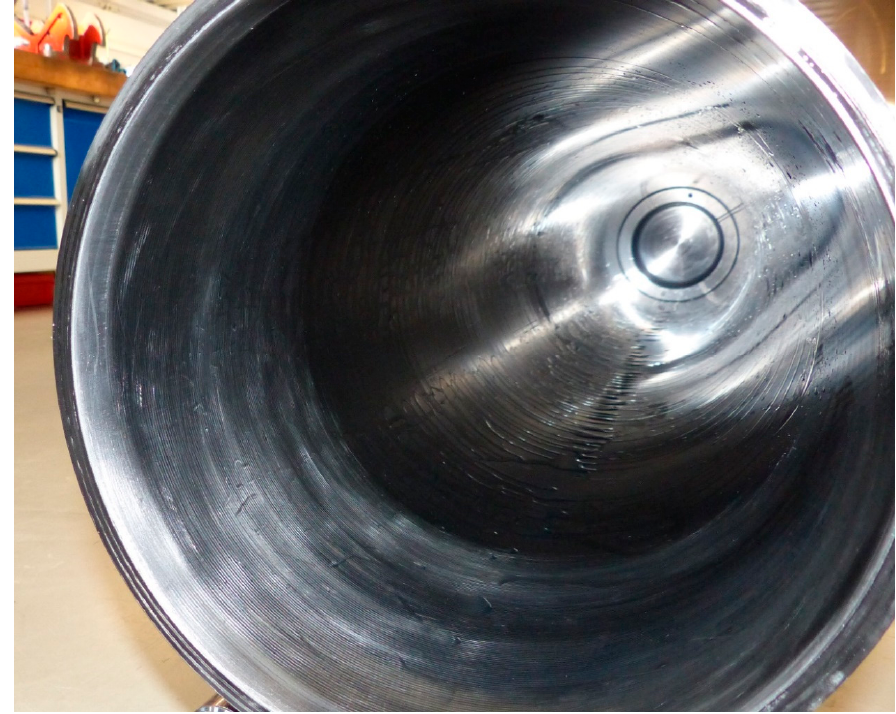
Figure 9. A prototype of a CFRP piston accumulator with a steel liner on the inner surface of the CFRP